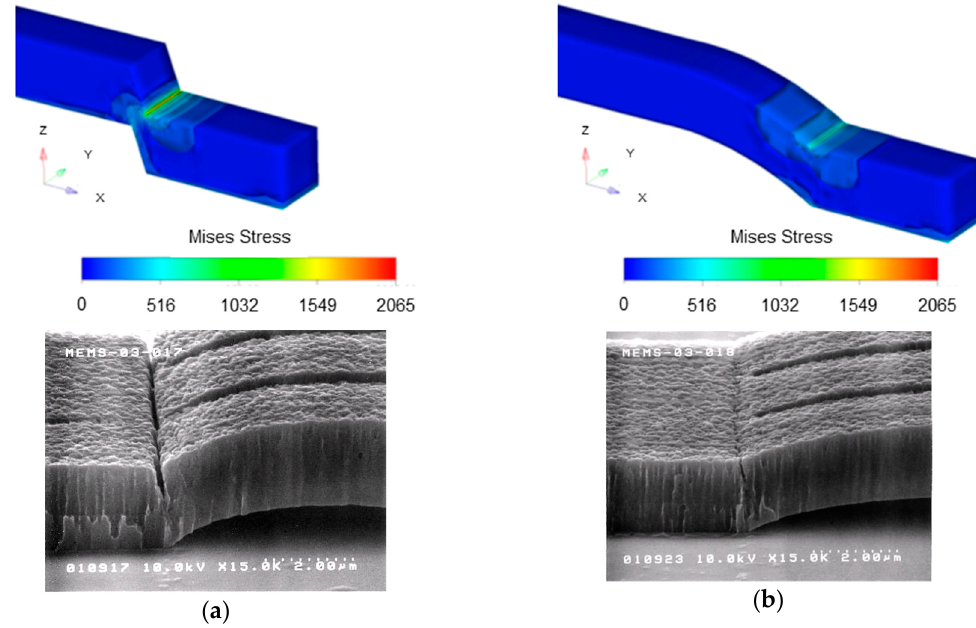
Figure 5. Simulated stress and scanning electron microscope (SEM) images of support area at post-bake temperature for sacrificial photoresist: ( a ) 150 ° C; ( b ) 180 ° C.